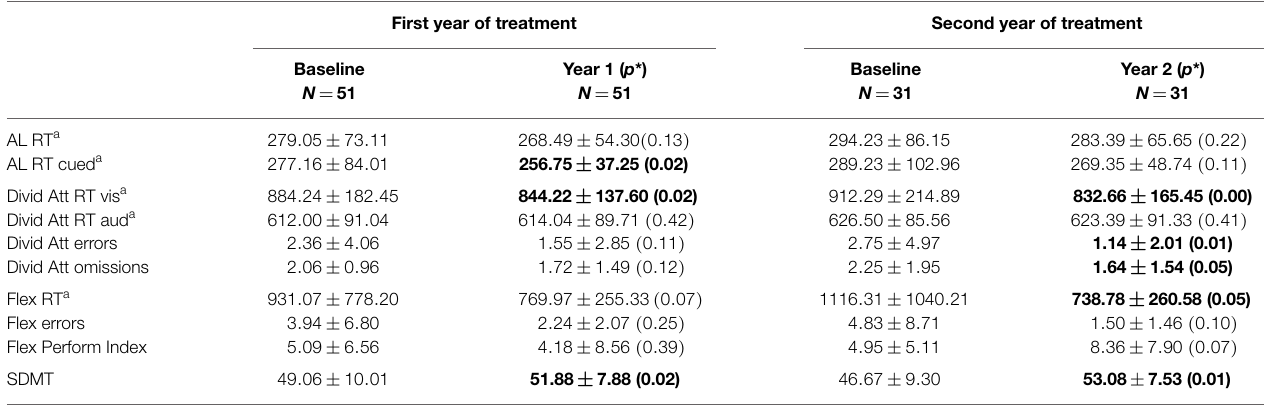
TABLE 3 | Changes in different aspects of attention over 2years of treatment with NTZ .